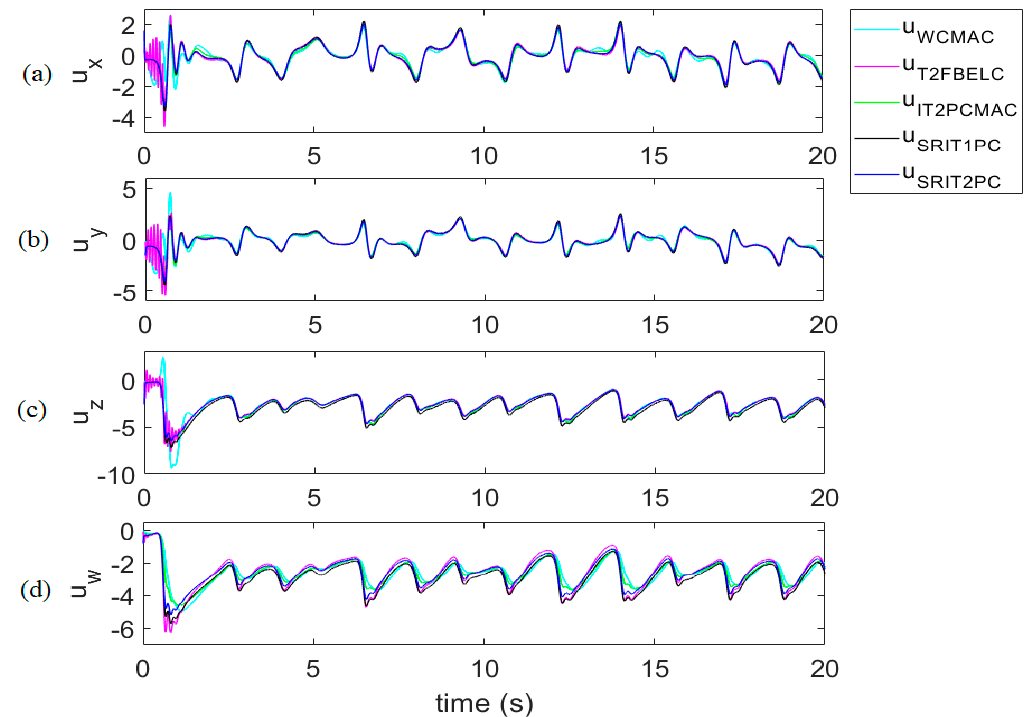
Figure 14. Control signals between the proposed SRIT2PC and other synchronization methods for Case 2: ( a ) u x , ( b ) u y , ( c ) u z , and ( d ) u w .